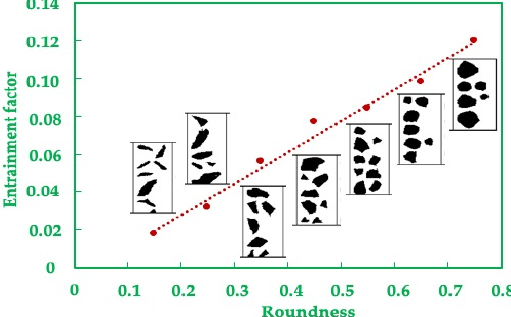
Figure 29. The relationship between entrainment factor in flotation and particle roundness (modified from [155]).